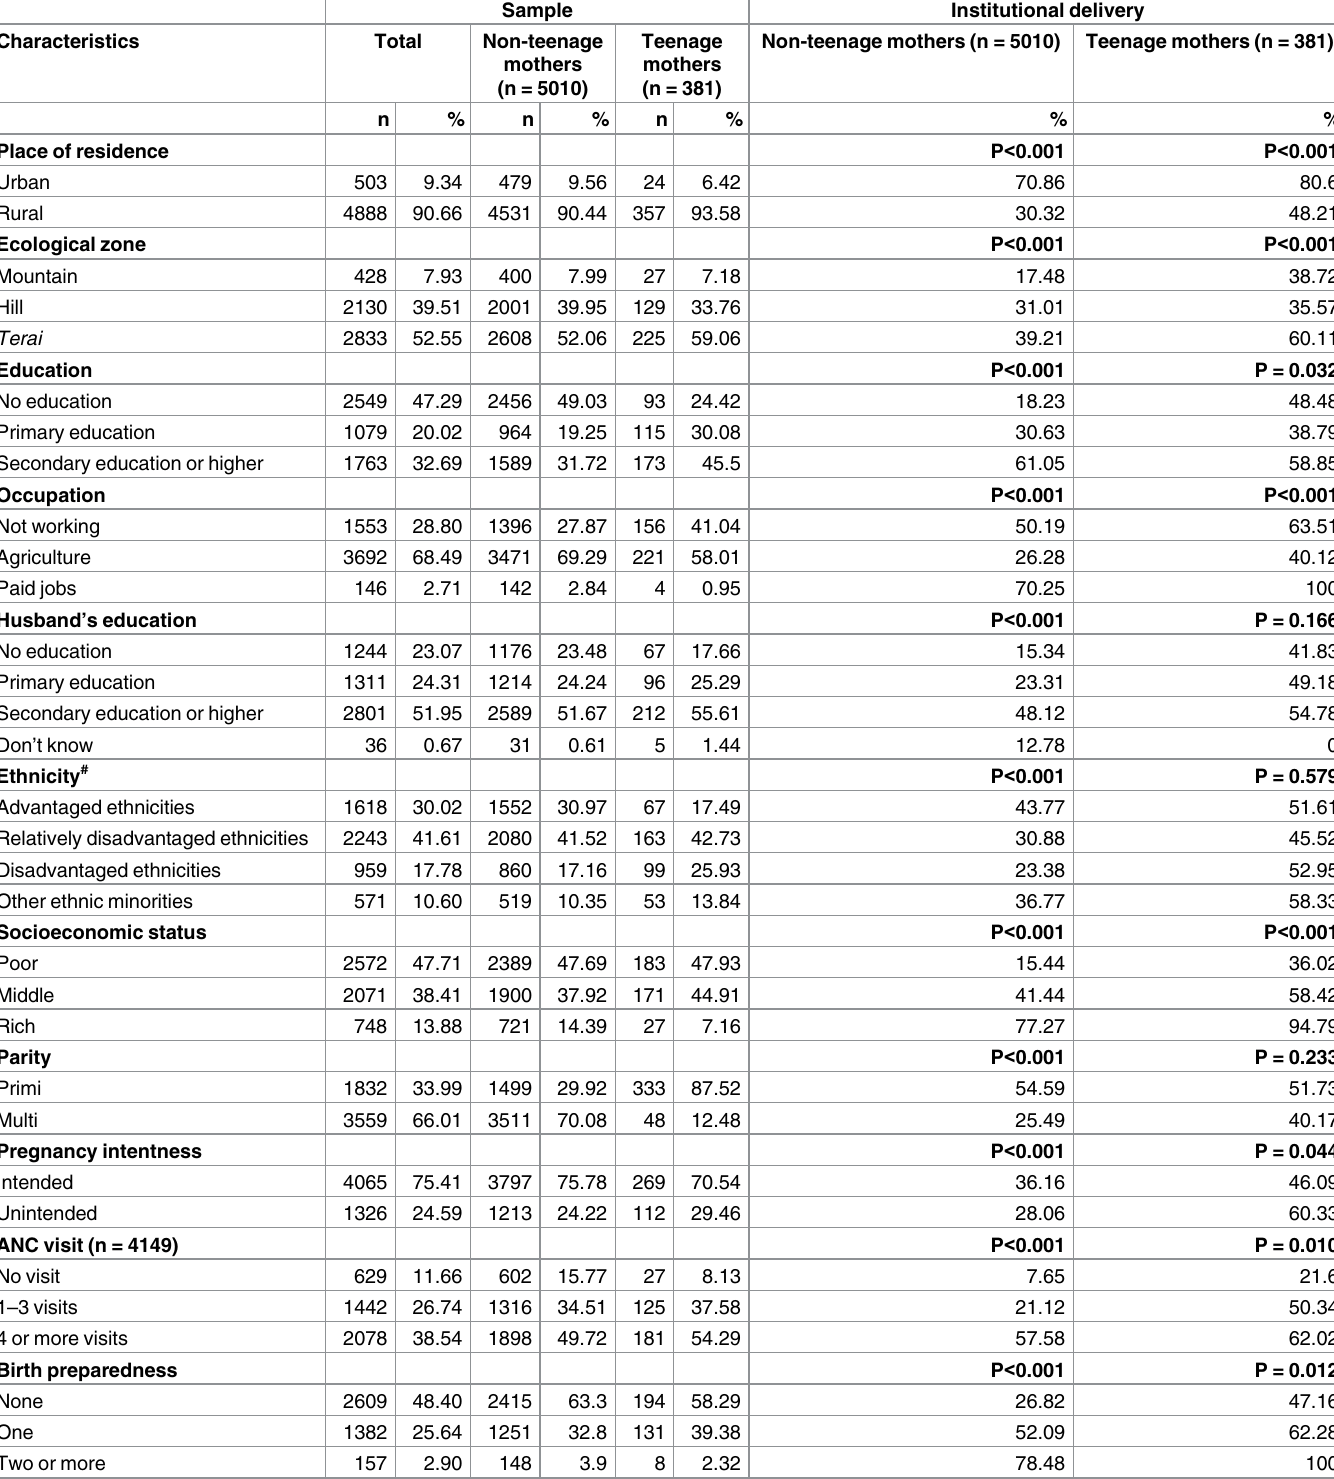
Table 1. Distribution of teenage and non-teenage mothers delivered at the health facility according to their background characteristics-NDHS 2011 (N = 5391).